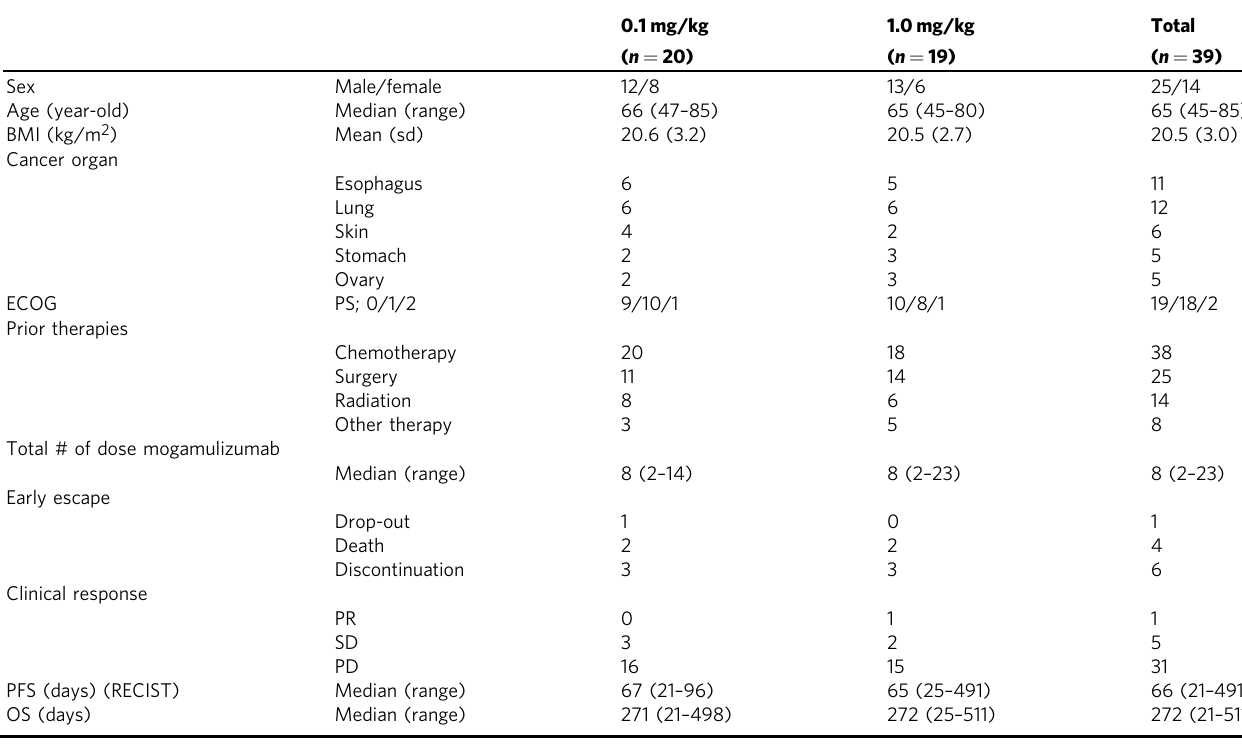
Table 1 Patient characteristics and clinical responses.